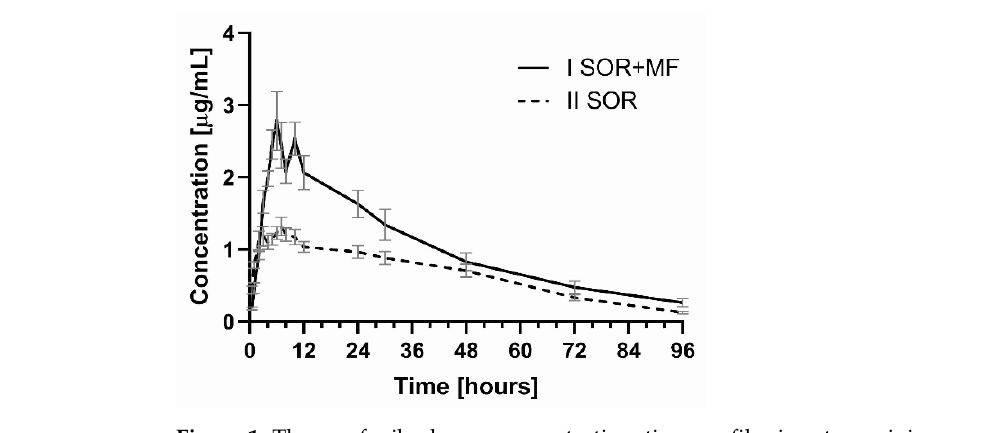
Table 2. Pharmacokinetic parameters of morphine and its metabolite M3G after a single intraperitoneal dose of 5 mg/kg b.w. of morphine (III MF group) and a single oral dose of 100 mg/kg b.w. of sorafenib + single intraperitoneal dose of 5 mg/kg b.w. of morphine (I SOR+MF group).